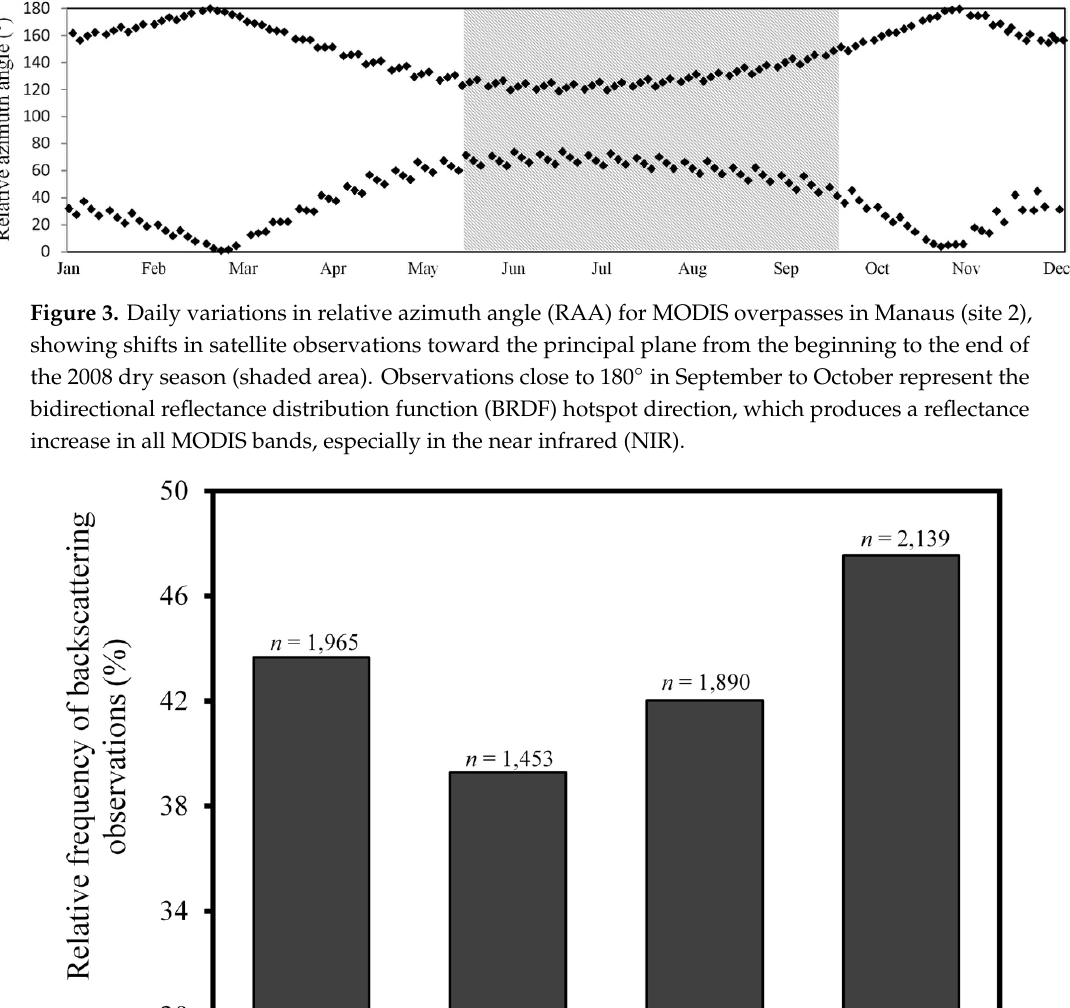
Figure 2. Seasonal variations in the ( a ) relative frequency of high–quality pixel retrievals, ( b ) view zenith angle (VZA), and ( c ) solar zenith angle (SZA) for the three sites selected from north to south of the Amazon. The location of the sites is indicated in Figure 1. Results refer to 2008, a non–drought year.